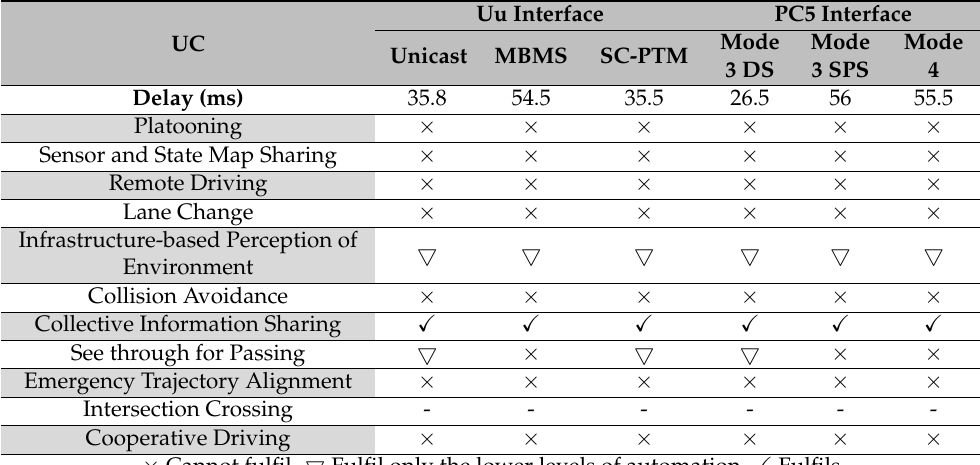
Table 10. 3GPP use case (UC) evaluation for LTE-A.